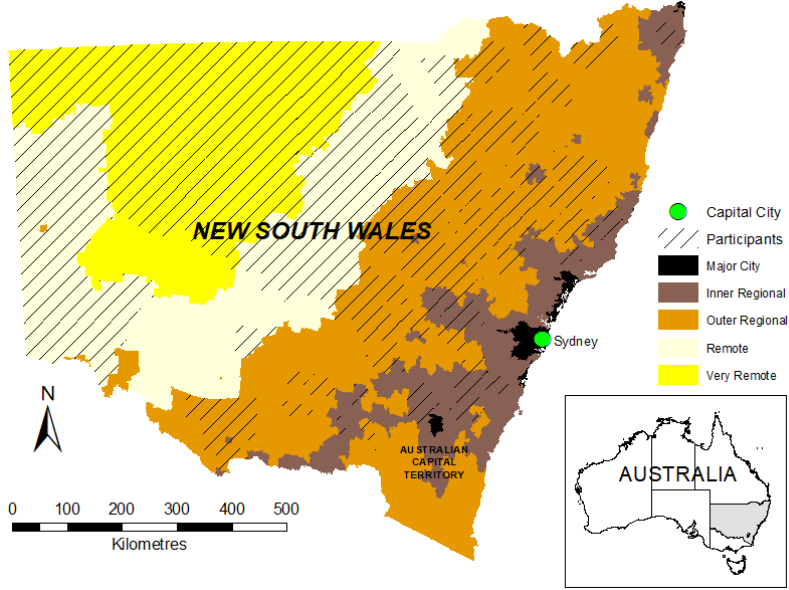
Figure 2. Location of study population in New South Wales (NSW) according to postcode and remoteness class [33].